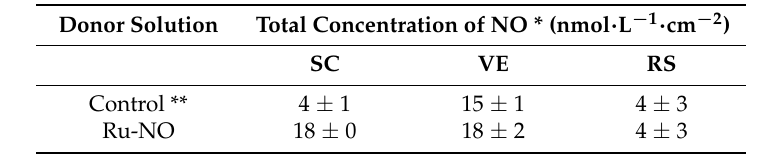
Table 2. Nitric oxide quantified in SC, viable epidermis (VE), and receptor solution (RS) after 4 h